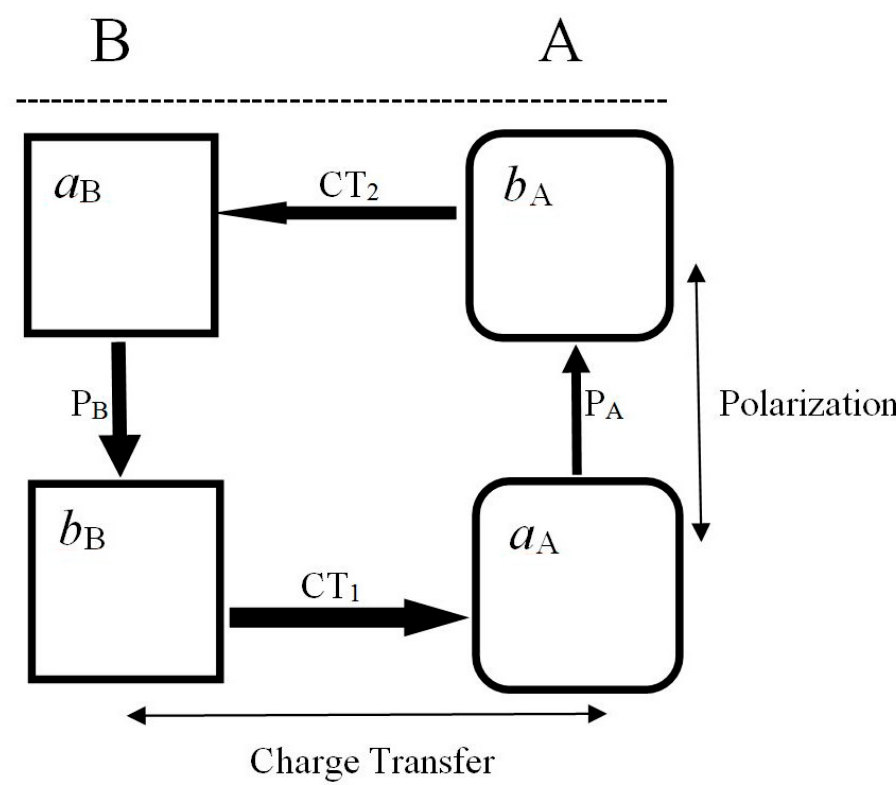
Figure 1. The Charge-Transfer (CT) { b X → a Y } and Polarizational (P X ) { a X → b X } electron flows involving acidic A = ( a A | b A ) and basic B = ( a B | b B ) reactants in the complementary arrangement R c of their acidic ( a ) and basic ( b ) sites in reactive complex R = (A | B). These electronic flows are seen to produce an e ff ective concerted (circular) flux of electrons in the equilibrium reactive system R * = (A * ¦ B * ) = ( a A* ¦ b A* ¦ a B* ¦ b B* ) as a whole, with all fragments exhibiting the “flow-through” current pattern, which precludes an exaggerated depletion or accumulation of electrons on any site in reactive